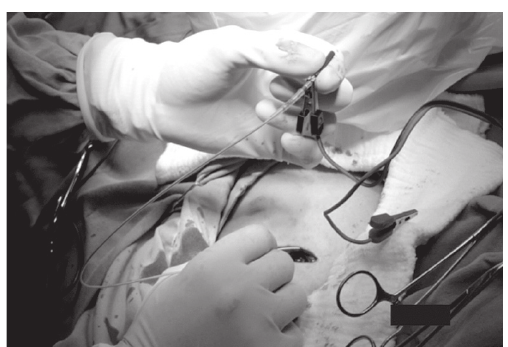
Fig. 1 - Foto demonstrando o procedimento para obtenção de eletrograma intracavitário unipolar. Observe que o anel distal do eletrodo é conectado ao eletrodo explorador por meio de um fio de condução elétrica.